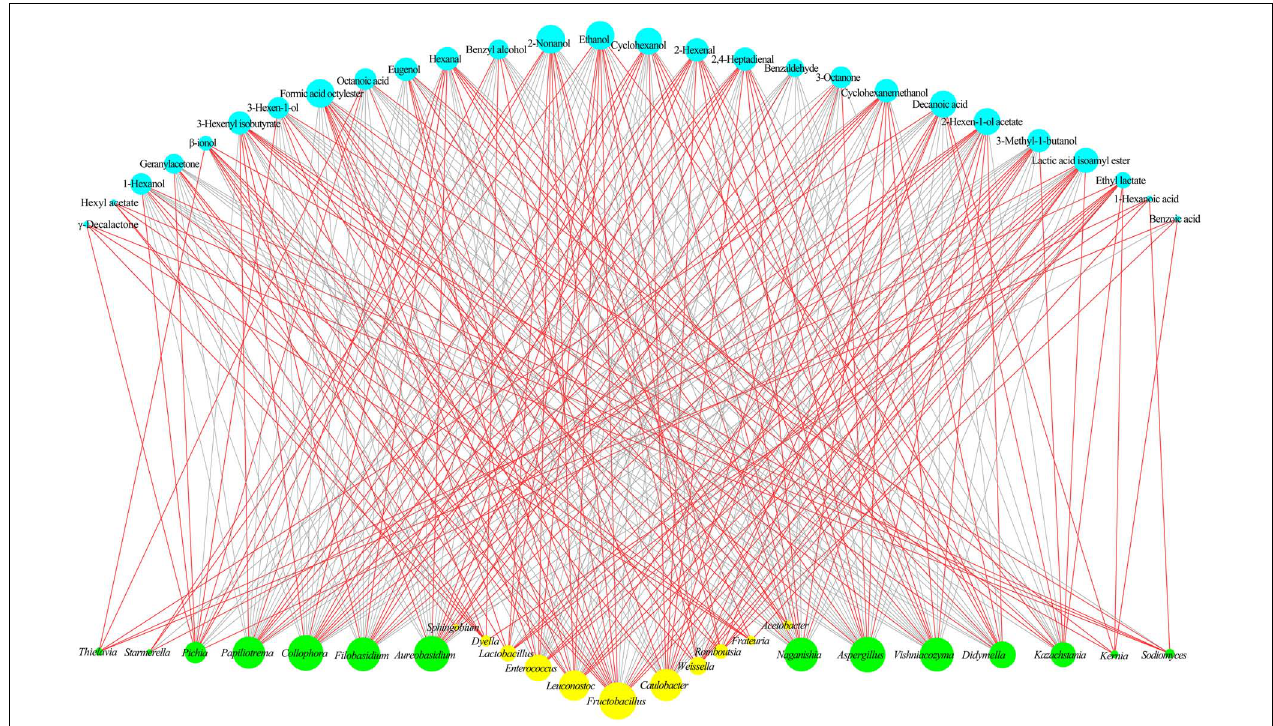
FIGURE 7 | Correlation analyses between the microbiota and volatile compounds during fermentation. The core fungal and bacterial genera are shown in yellow and green, respectively. The core volatile compounds are shown in blue. Red and gray lines indicate positive and negative correlations, respectively.